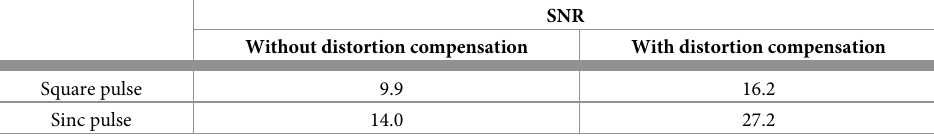
Table 3. SNR values measured by using uncompensated and compensated pulses (square and sinc